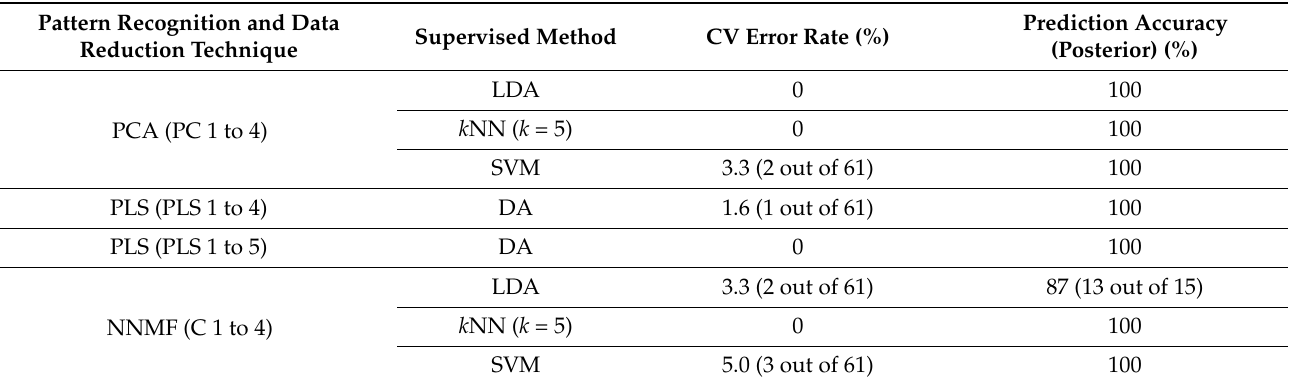
Table 1. Prediction results for 4 labels. (L)DA = (linear) discriminant analysis; k NN, k -nearest neighbor classification, k = number of neighbors; SVM = support vector